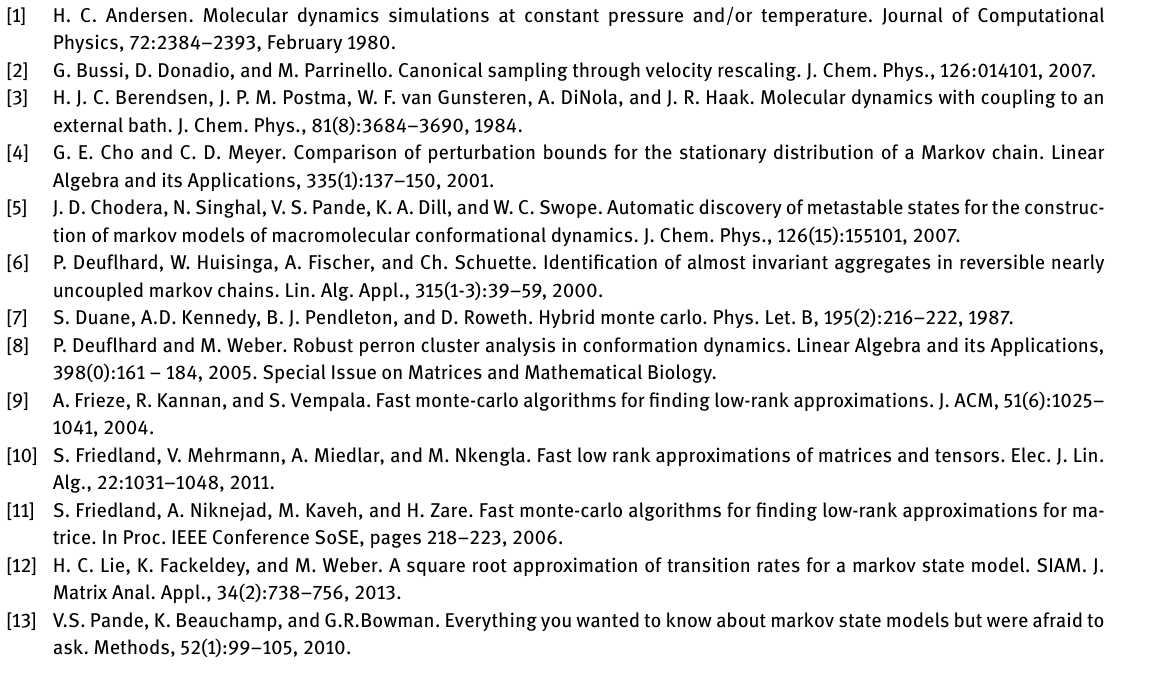
matrix P . The linear subspace is expressed by membership vectors, which are non-negative vectors and form a partition-of-unity